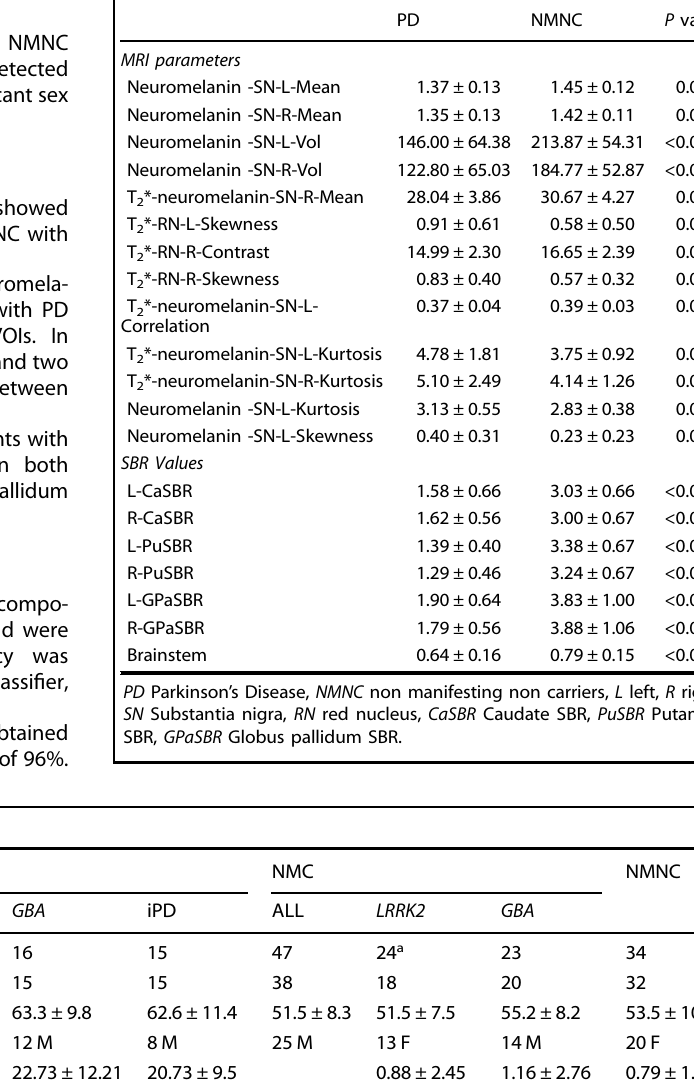
Table 2. Neuroimaging parameters: differences between patients with PD and NMNC.